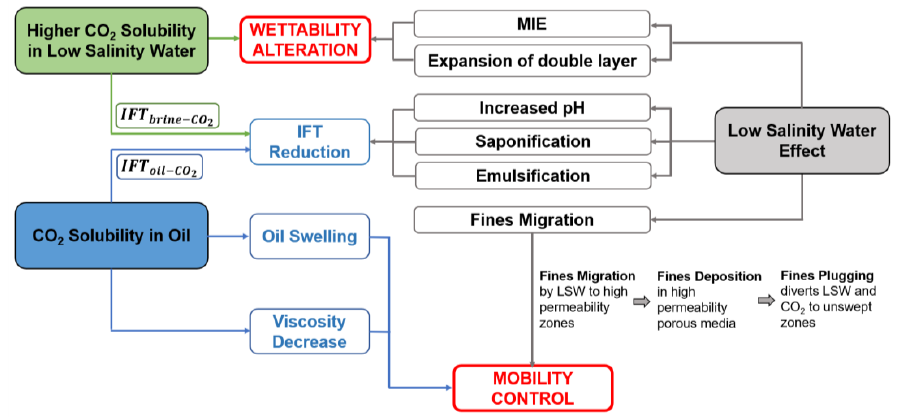
Figure 14. Proposed combined mechanisms of LSWI and CO 2 WAG injection in sandstone.